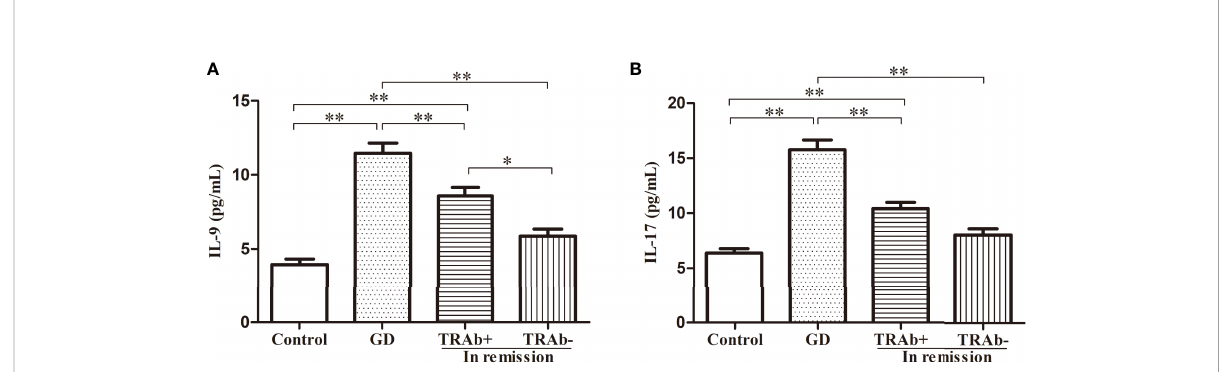
FIGURE 4 IL-9 and IL-17 plasma levels in patients with Graves ’ disease (GD) at different stages and controls. * P < 0.05, ** P < 0.01. TRAb, thyroid- stimulating hormone receptor antibody. Represented by (A and B)